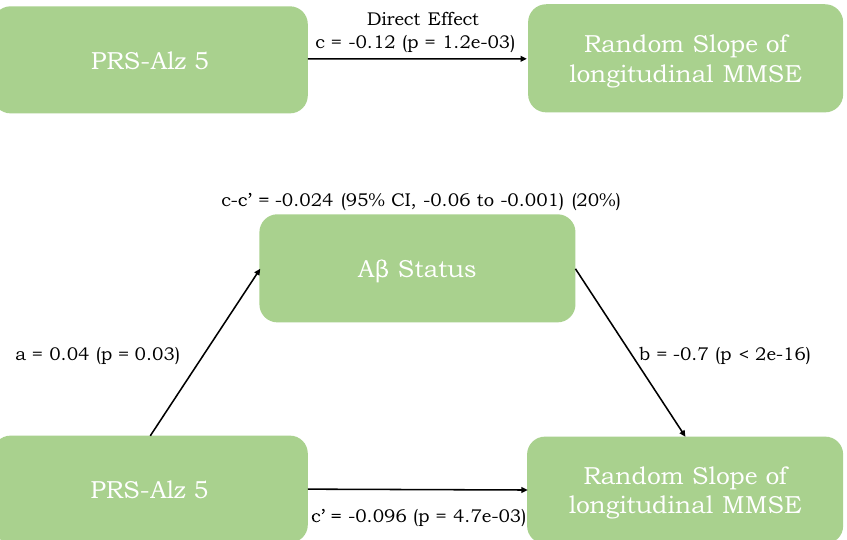
Figure 3. Mediation analysis between PRS, Aβ status and cognition. Mediation analysis with PRS-Alz 5 (predictor), mediated by Aβ status predicting the cognitive decline (slope of longitudinal MMSE). The figure includes the following standardized regression coefficients: a, the effects of PRS/PGS on Aβ; b, the effects of Aβ on the random slope of longitudinal MMSE score; c, the direct association between PRS and slope of longitudinal MMSE score; c’, the association between PRS and slope of longitudinal MMSE score when adjusting for Aβ; and c–c’, the mediated effect on the slope of longitudinal MMSE (with %